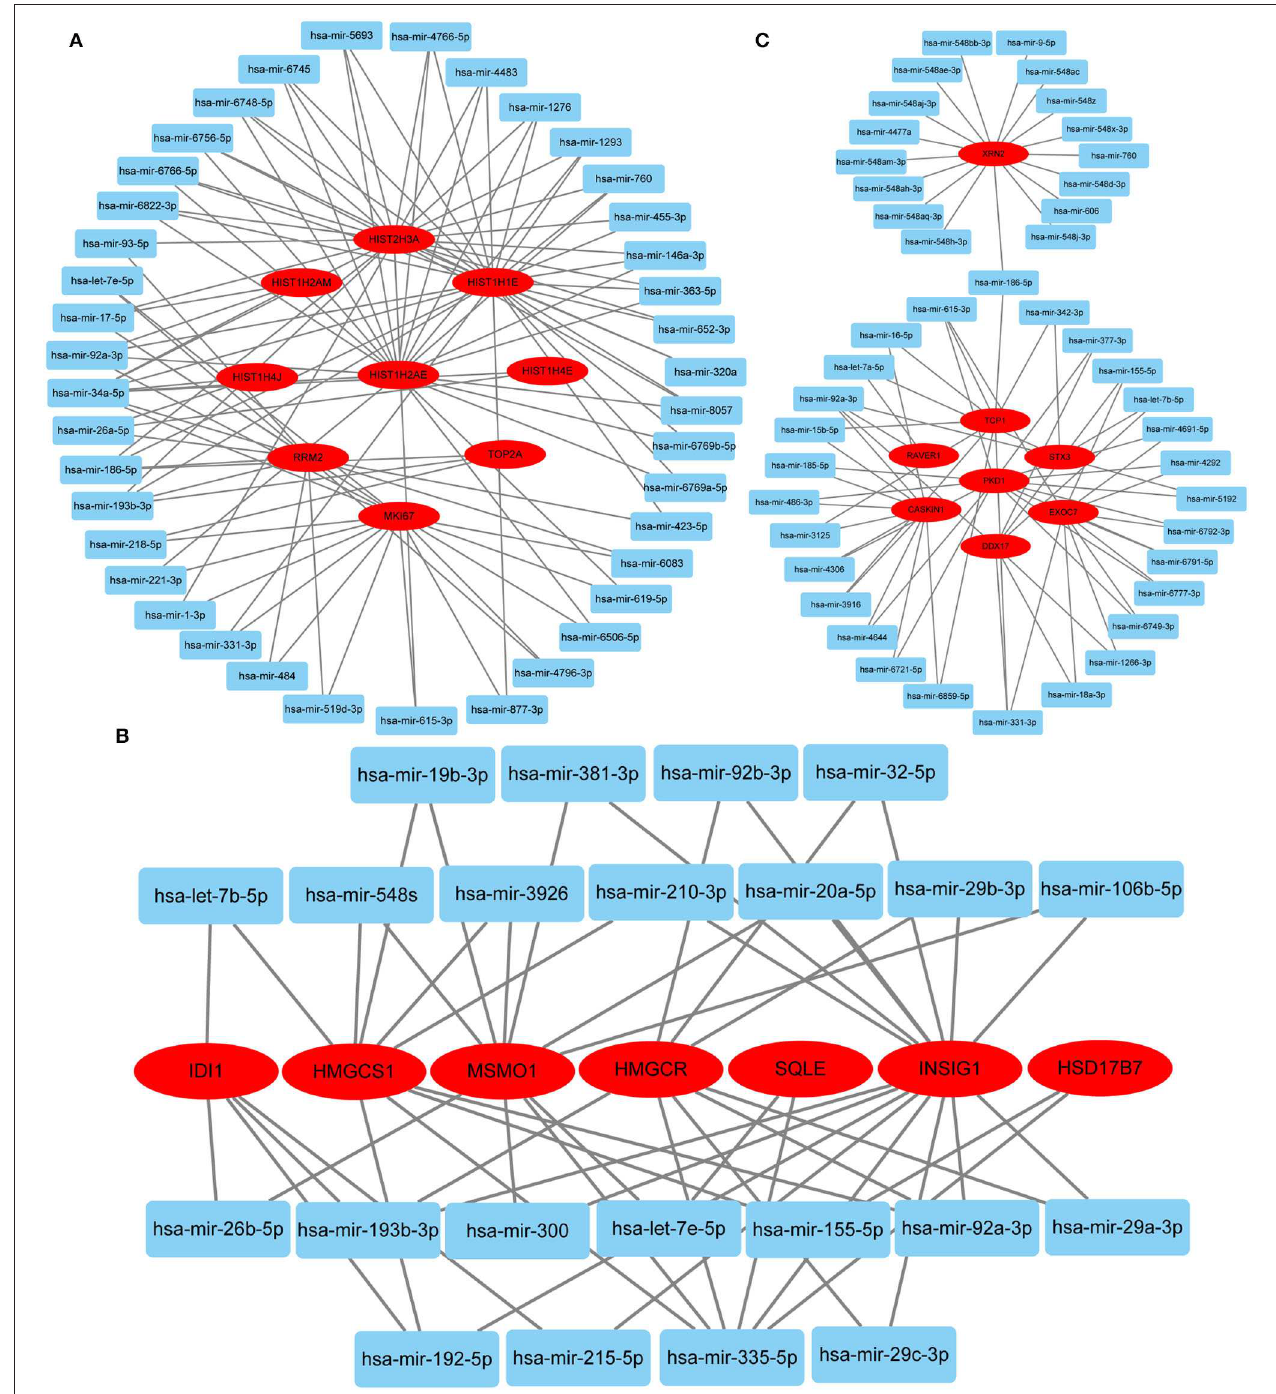
FIGURE 8 | Gene-miRNA regulatory network. (A) Early stage (5h); (B) late stage (24h); (C) common stage. The background colors of genes and miRNAs are red and light blue, respectively. The sole connection of the gene-miRNA is